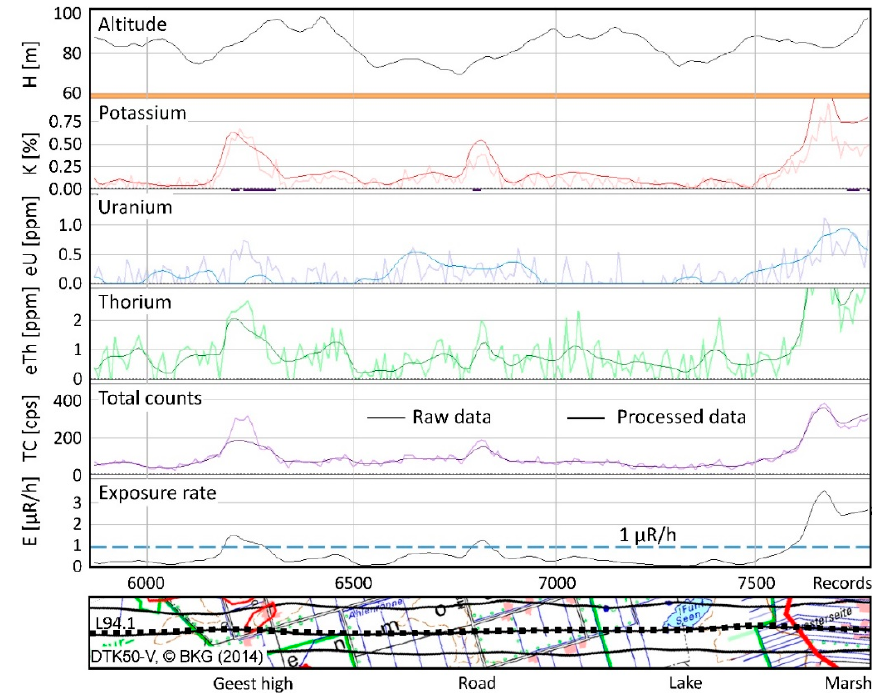
Figure 11. Helicopter-borne radiometrics (HRD) data example along the western portion of flight line L94.1 (see extract from a flight-line map at the bottom) showing (from top to bottom): HRD sensor altitude (H), radioelements potassium (K), uranium (U), thorium (Th), and the total counts (TC) (raw and processed data), as well as the exposure rate (E). The black horizontal lines beneath the potassium panel indicate erased and interpolated data sections.